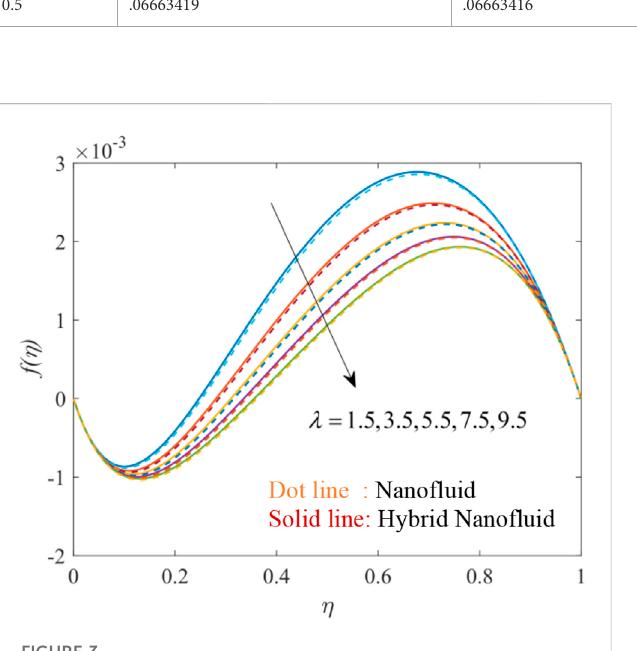
FIGURE 3 Effect of porosity parameter λ on f ( η ) .